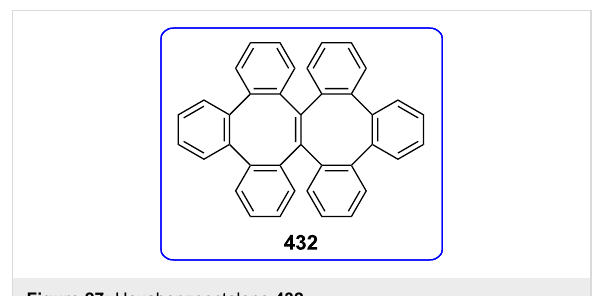
Figure 27: Hexabenzooctalene 432